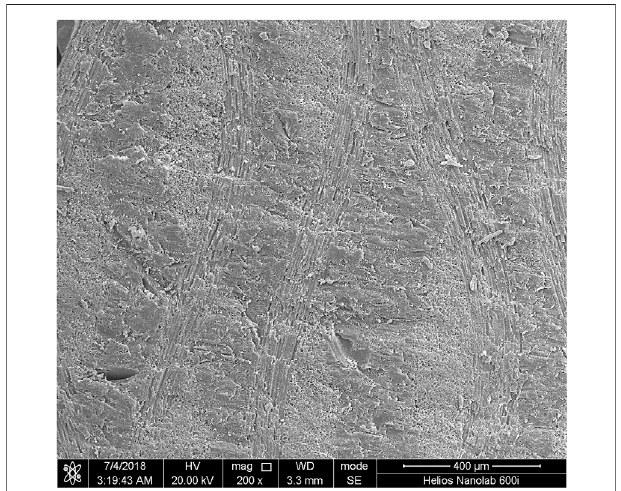
FIGURE 1 | SEM cross-sectional view of the studied hybrids.